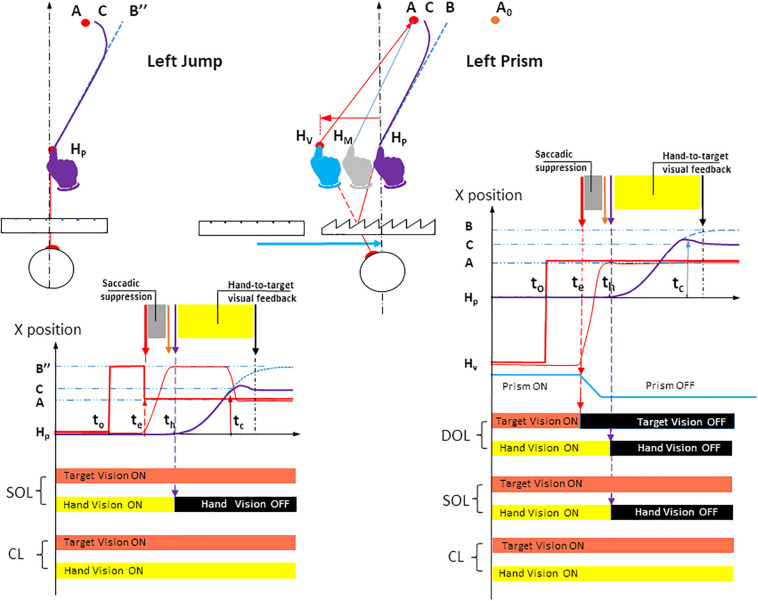
Spatial paths and temporal timings of visuomotor conditions in Jump and Prism experiments for a left deviation. The instructions given to participants were identical in both Jump and Prism experiments: point from the fixation point HP to the peripheral target as quickly and accurately as possible. Left upper panel: the Jump experiment. After a 1 s fixation on the target HP, a peripheral target appeared in B″, while the fixation target was cut off. Saccade onset triggered a target jump from B″ to A. As a result, the planned hand movement directed toward B″ (blue dotted line) caused a planning error B″A, and was corrected toward C (bold purple line). The blue dotted line represents the hand movement toward a stationary target B″ (i.e., the planned movement). Jump amplitude BA was equal to the mean horizontal planning error BA measured in the Prism experiment. The Jump could occur from a point B″ located either to the left or right (not represented) of A. During stationary trials, the target did not jump, and remained at B″. The jump deviation factor consisted of four states: stationary B″, B″ to A jump (for a left jump), and the symmetrical configuration (not represented) for a right jump. Null deviation corresponded to the interpolation of right and left stationary trajectories. Left lower panel: Timing of stimuli and responses for the Jump experiment. Bold red lines represent the seen target stimulus. Bold red segments, lateral positions of the seen target; Dotted blue line, (lateral direction of) planned hand pointing, obtained when B″ is stationary; Bold purple line, (lateral direction of) hand pointing with correction; Thin red line, lateral direction of eye saccade; t0, appearance of peripheral target B″; te, saccade onset, triggering a target jump from B″ to A; th, hand movement onset; tc, correction latency; HP, physical fixation target; B″, peripheral target before target jump; A, peripheral target after target jump; C, the final point of the movement after correcting for the deviation. The visuomotor loop factor had two states in the Jump experiment. Single open loop (SOL): target vision was ON throughout the trial and hand vision was ON until hand movement onset th (thin dotted purple vertical arrow), then OFF until trial end. Closed loop (CL): target and hand vision were both ON throughout the trial. Right upper panel: Prism. See Figure 1 (upper left) for the meaning of symbols and colors. Prism deviation could be to the left, right (see Figure 1, upper right), or null. Right lower panel: Timings of stimuli and responses for the Prism experiment. The visuomotor loop factor had three states. Double open loop (DOL): target was ON until saccade onset te then OFF until trial end, hand vision was ON until hand movement onset th then OFF until trial end. Single open loop (SOL): target vision was ON throughout the trial and hand vision was ON until hand movement onset th (thin dotted purple vertical arrow), then OFF until trial end. Closed loop (CL): target and hand vision were both ON throughout the trial. Bold red segments: lateral positions of the seen target; Dotted blue line: (lateral direction of) planned hand pointing; Bold purple line: (lateral direction of) hand pointing; Thin red line: lateral direction of eye saccade; t0, appearance of peripheral target A; te, saccade onset; th, hand movement onset; tc, correction latency. HP, physical fixation target; HV, seen fixation target; A, seen peripheral target; B, the final point of the movement initially planned; C, the final point of the movement after correcting for the deviation. Figure 1 shows that this configuration enables a Prism/Jump comparison for the same erroneous planning (HPB and HPB″) toward A.